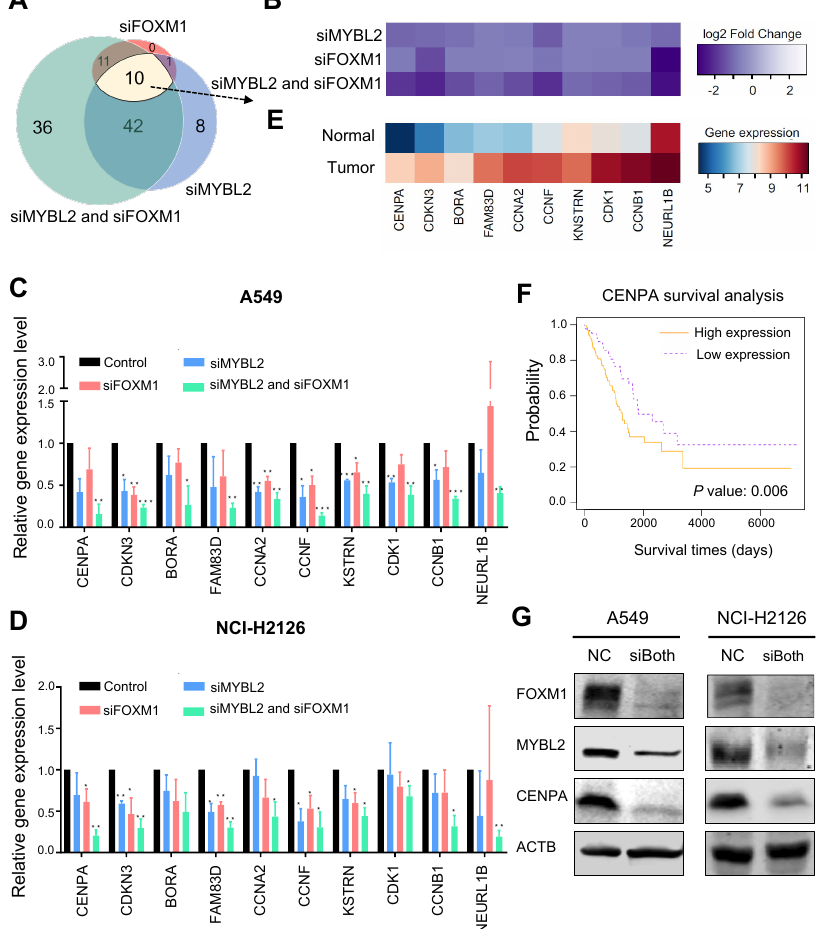
Figure 4. Identification of MYBL2 and FOXM1 target genes in lung adenocarcinoma cells. ( A ) A Venn diagram showing the overlapped genes among the MYBL2 and FOXM1 target genes, identified by the downregulated genes in siFOXM1 (pink), siMYBL2 (blue), and siMYBL2 and siFOXM1 (green) experiments with promoters bound by MYBL2, FOXM1, or both. ( B ) A heatmap showing the log2 fold change gene expression of the identified MYBL2 and FOXM1 target genes from the knockdown RNA-seq experiments. siFOXM1, siMYBL2, and siMYBL2 and siFOXM1 RNA-seq data are compared to corresponding siControl RNA-seq data. Validation of downstream targets of both MYBL2 and FOXM1 using RT-qPCR upon knockdown experiments in ( C ) A549 cells and ( D ) NCI-H2126 cells. Data represent the mean SE ( n = 3). *, p -value ≤ 0.05, **, p -value ≤ 0.01, ***, p -value ≤ 0.001. ( E ) A heatmap showing the expression levels of the identified MYBL2 and FOXM1 target genes in TCGA LUAD RNA-seq datasets. ( F ) A survival analysis indicates that overexpression of CENPA is associated with poor survival of lung adenocarcinoma patients ( p -value = 0.006). TCGA LUAD RNA-seq and clinical data were used to perform this analysis. ( G ) FOXM1, MYBL2, and CENPA protein expression levels were analyzed upon knockdown of MYBL2 and FOXM1 by Western blot ( right ) ( n = 3). ACTB is used as a control. NC: negative